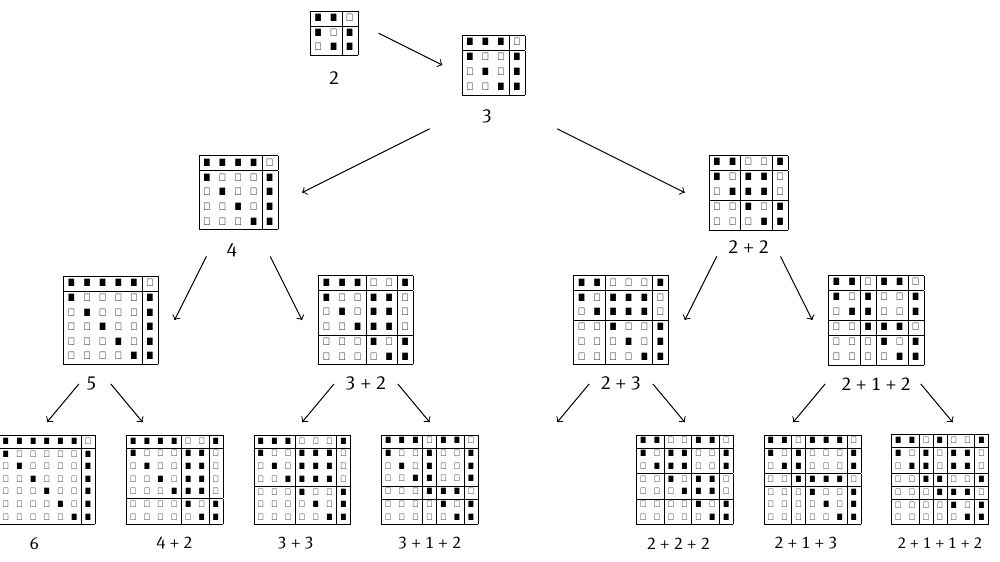
Figure 15: Upper Hessenberg matrix representations and integer compositions.